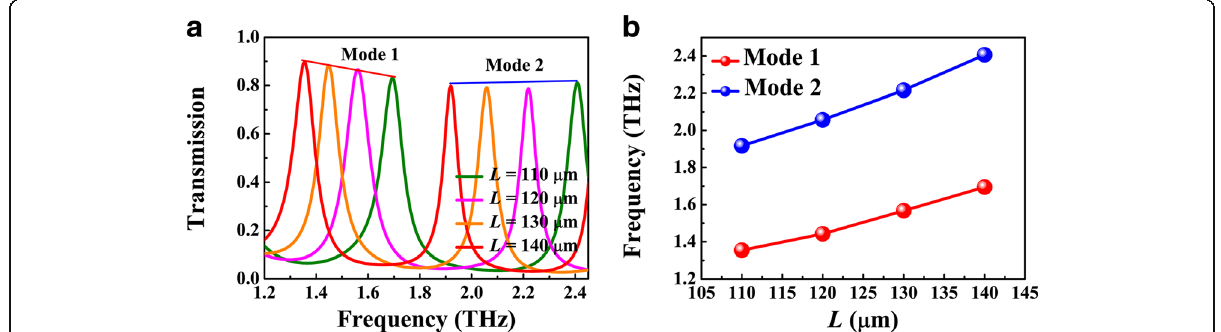
Fig. 5 a Numerical transmission spectra for different cavity length L . b Resonant frequencies of modes 1 and 2 as functions of the cavity length L . Here, g = 1 μ m, d = 5 μ m, and E F = 70